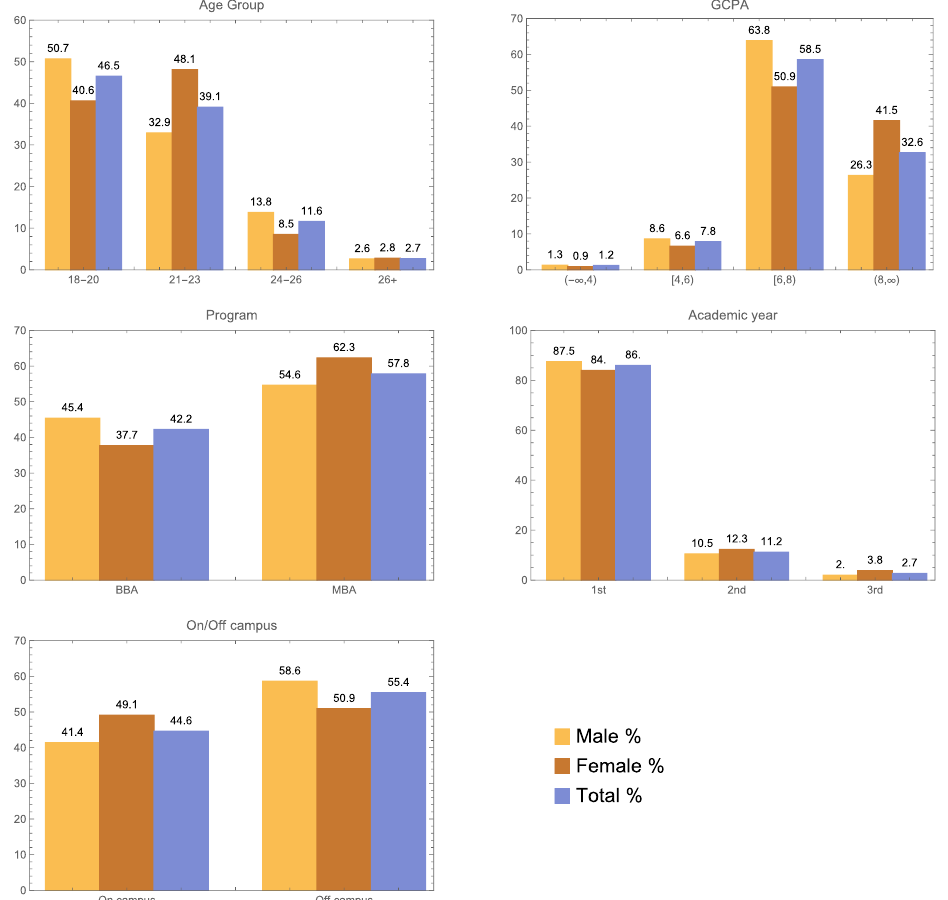
Figure 2. Distribution of population by the indicated background